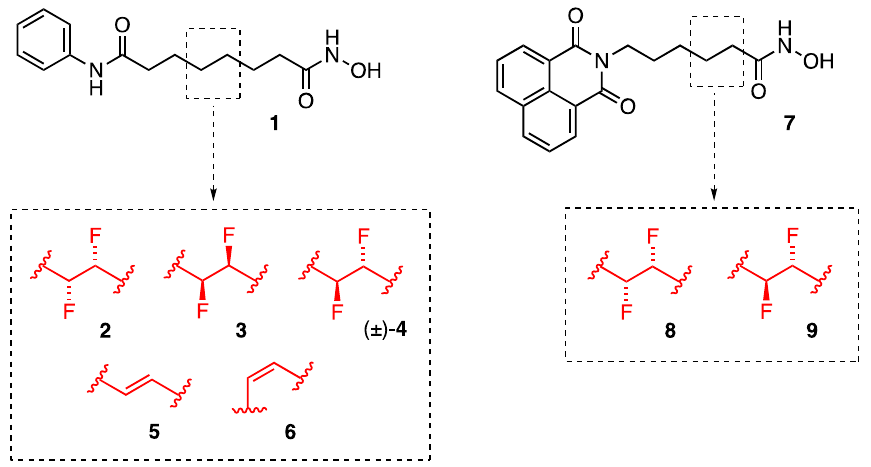
Figure 1. The known HDAC inhibitors SAHA ( 1 ) and Scriptaid ( 7 ), and the novel targets of this work (i.e., 2 – 6 , 8 , 9 ).